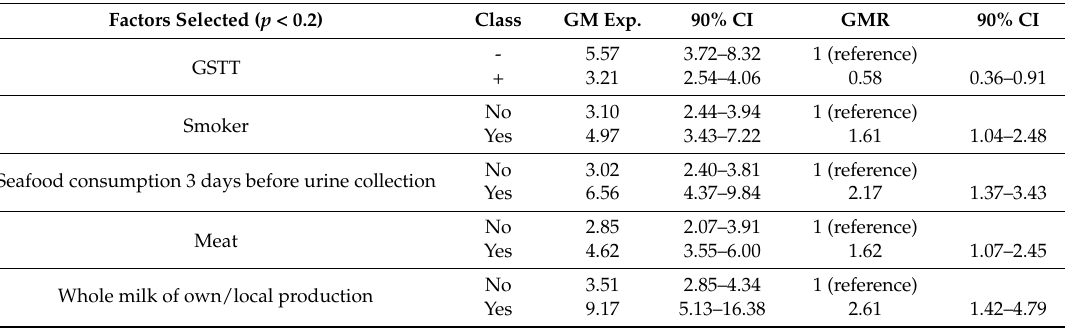
Table 4. Amiata sample. Factors associated with u(iAs+MMA+DMA) concentration by stepwise multivariate regression.